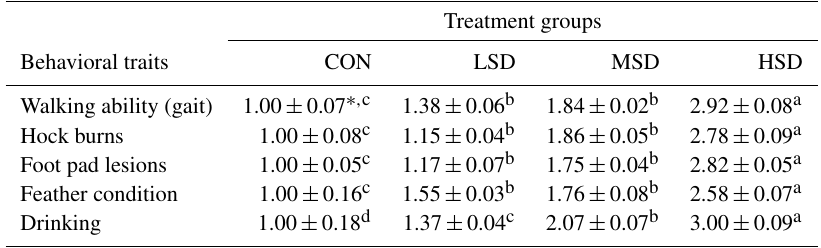
Table 6. Effect of stocking densities on the walking ability (gait), drinking frequency, presence of hock burn, presence of foot pad lesions, and feather condition scores in meat ducks exposed to heat